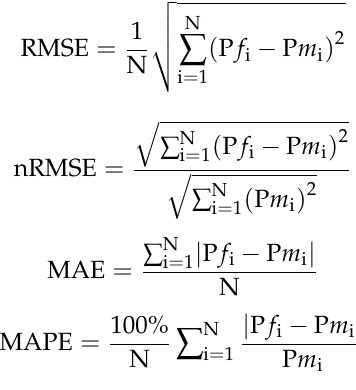
Irradiance Back Panel Surface Temperature Irradiance INV3 Back Panel Surface Temperature Irradiance INV6 Ambient Temperature